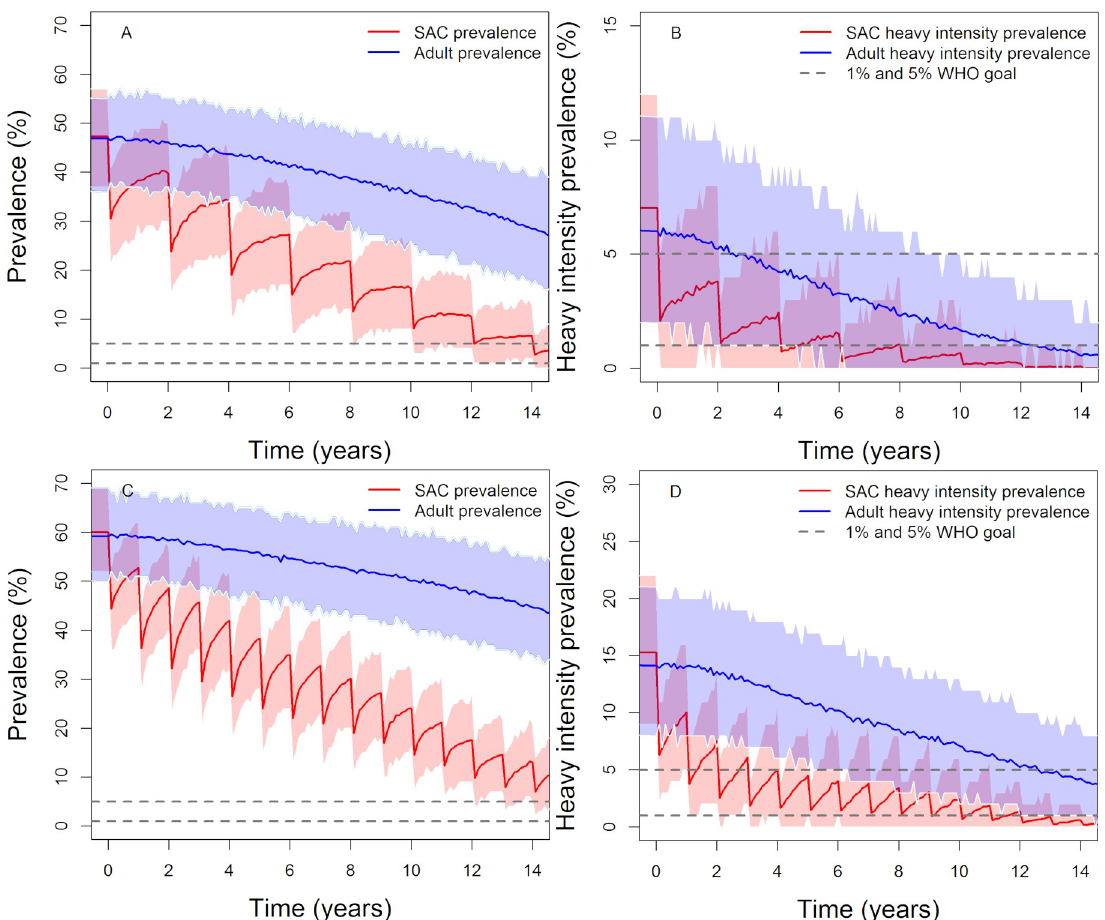
Fig 6. Model projections of vaccination in moderate (first row) and high (second row) baseline transmission settings. The duration of vaccine protection is set at 20 years vaccinating 85% of 1-year olds and giving MDA to 75% of SAC (annually in high transmission settings and once every two years in moderate transmission settings). Graph (A, C), show the prevalence of intensity and Graph (B, D) show the prevalence of heavy-intensity infections in school-aged children (SAC) and adults. Shaded areas (both blue and red) represent the 90% credible interval (90% of the simulated results fall within these shaded